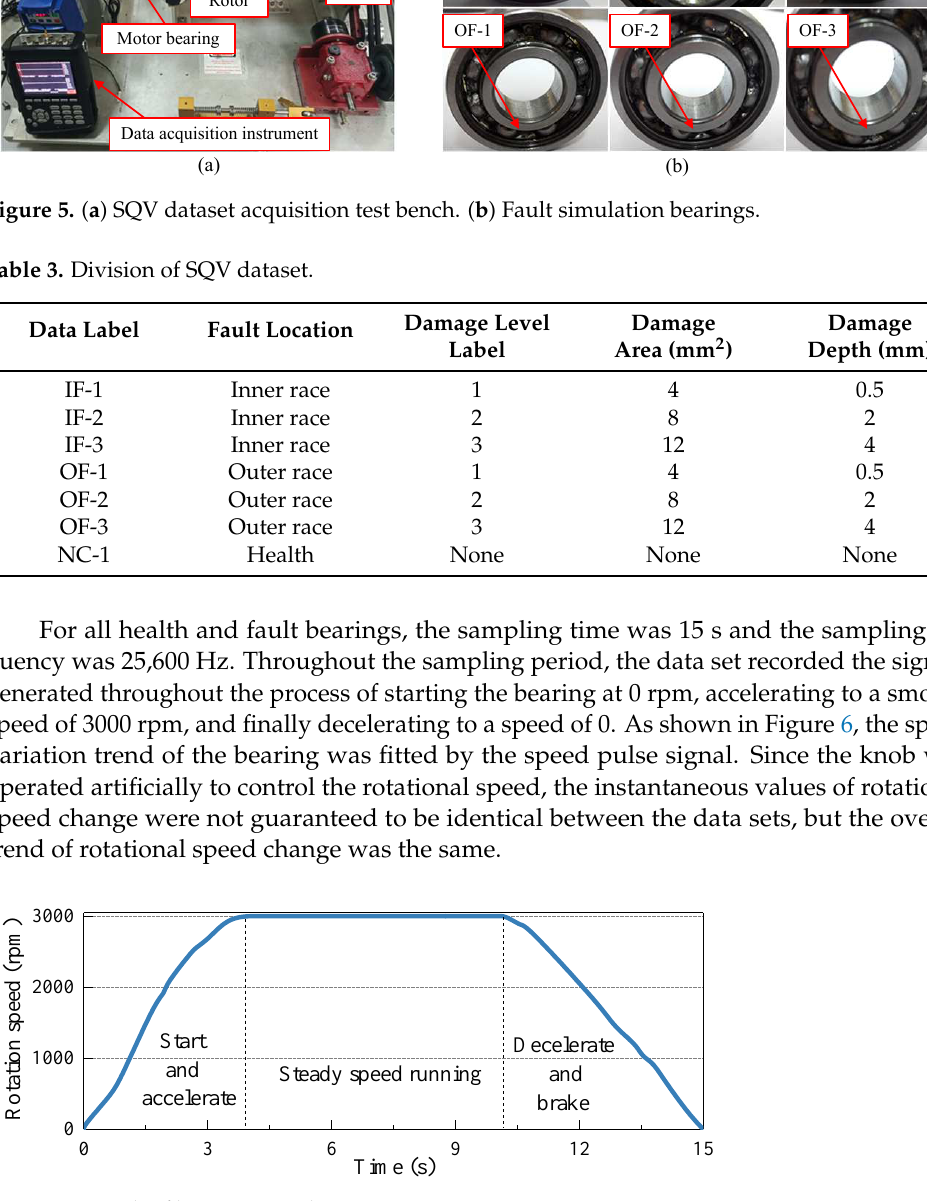
Figure 6. Graph of bearing speed